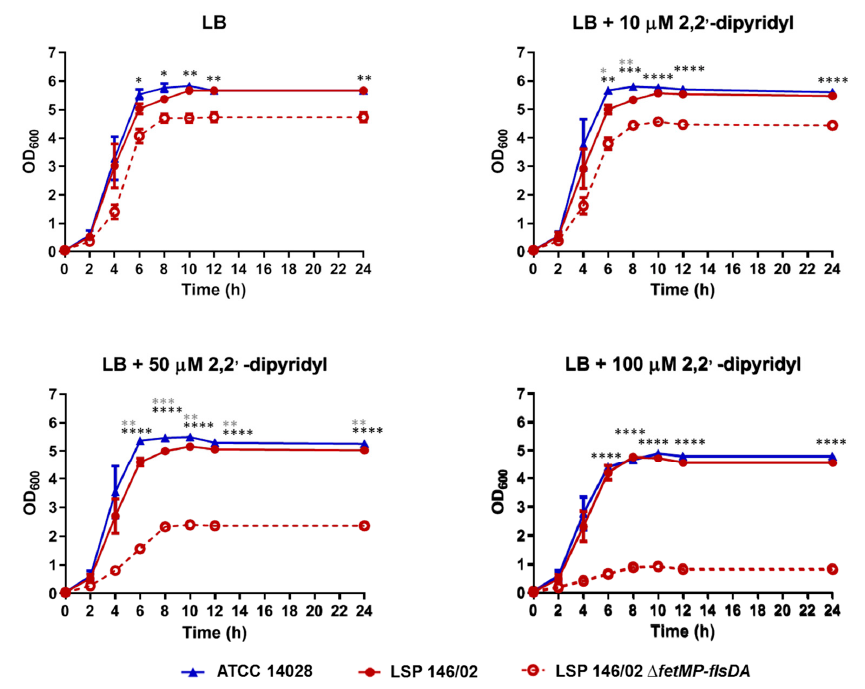
Figure 2. Growth curves obtained for S . Typhimurium ATCC 14028, wild-type S. Typhimurium LSP 146 / 02, and its isogenic ∆ fetMP - flsDA derivative using an LB broth supplemented with increasing concentrations of chelating agent 2,2 (cid:48) -dipyridyl. The data shown are the meanvalues ± standard deviations of three biological replicates. Statistical significance (**** p < 0.0001; *** p < 0.001; ** p < 0.01; * p < 0.05) was determined by ANOVA and the Tukey’s post-test. Black and grey asterisks show significant di ff erences for LSP 146 / 02 versus ∆ fetMP - flsDA and ATCC 14028,